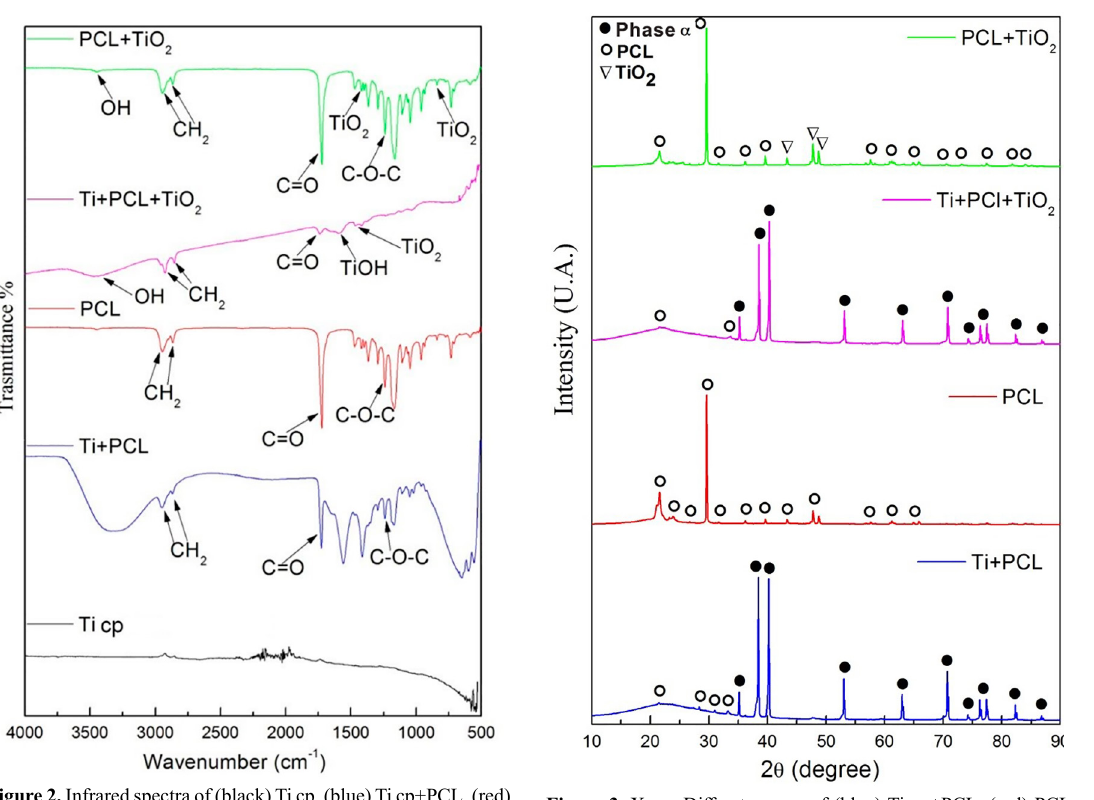
, and (green) PCL+TiO 2 2